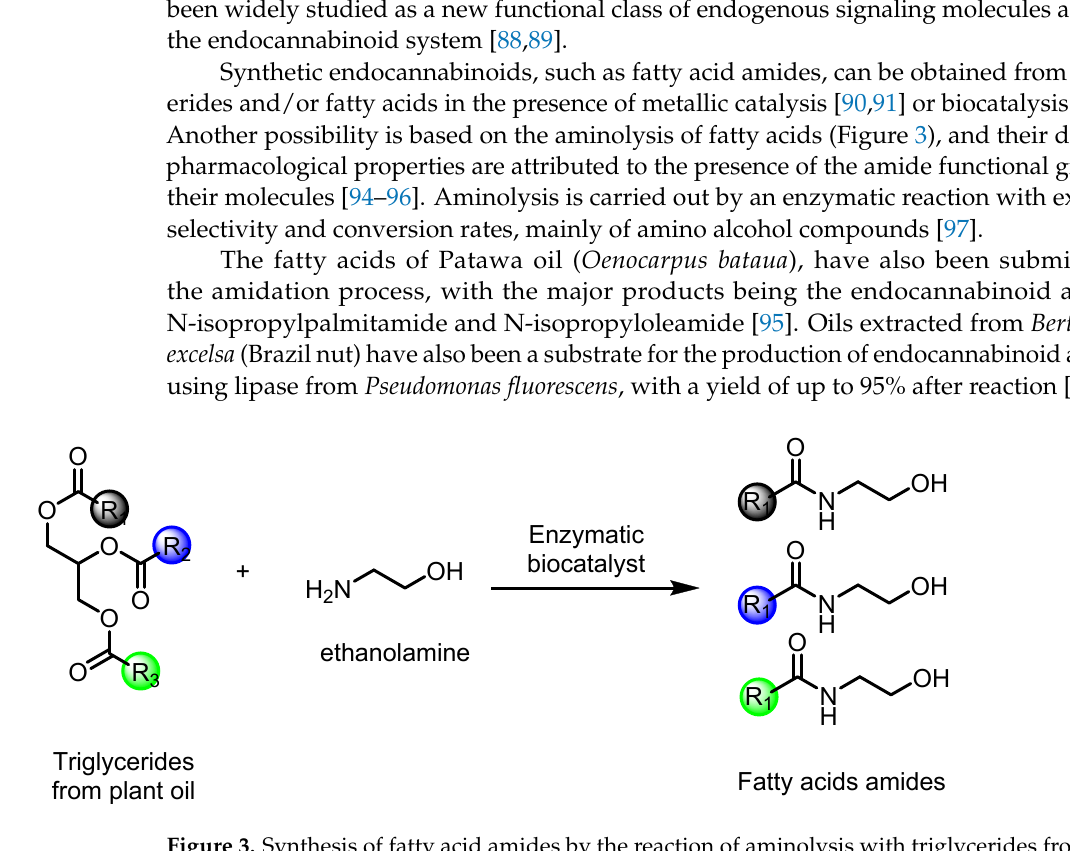
Figure 3. Synthesis of fatty acid amides by the reaction of aminolysis with triglycerides from plant oil and ethanolamine. R1, R2, and R3 are alkyl chains.